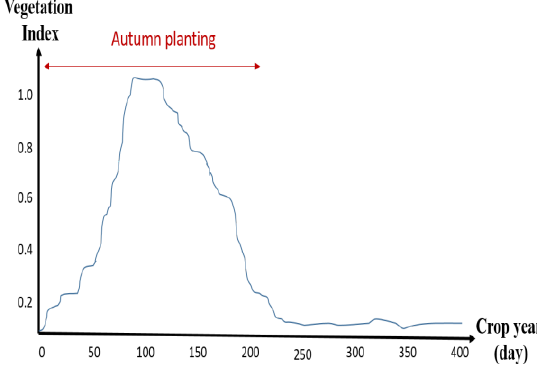
Figure (1). (A). Temporal response of autumn planting